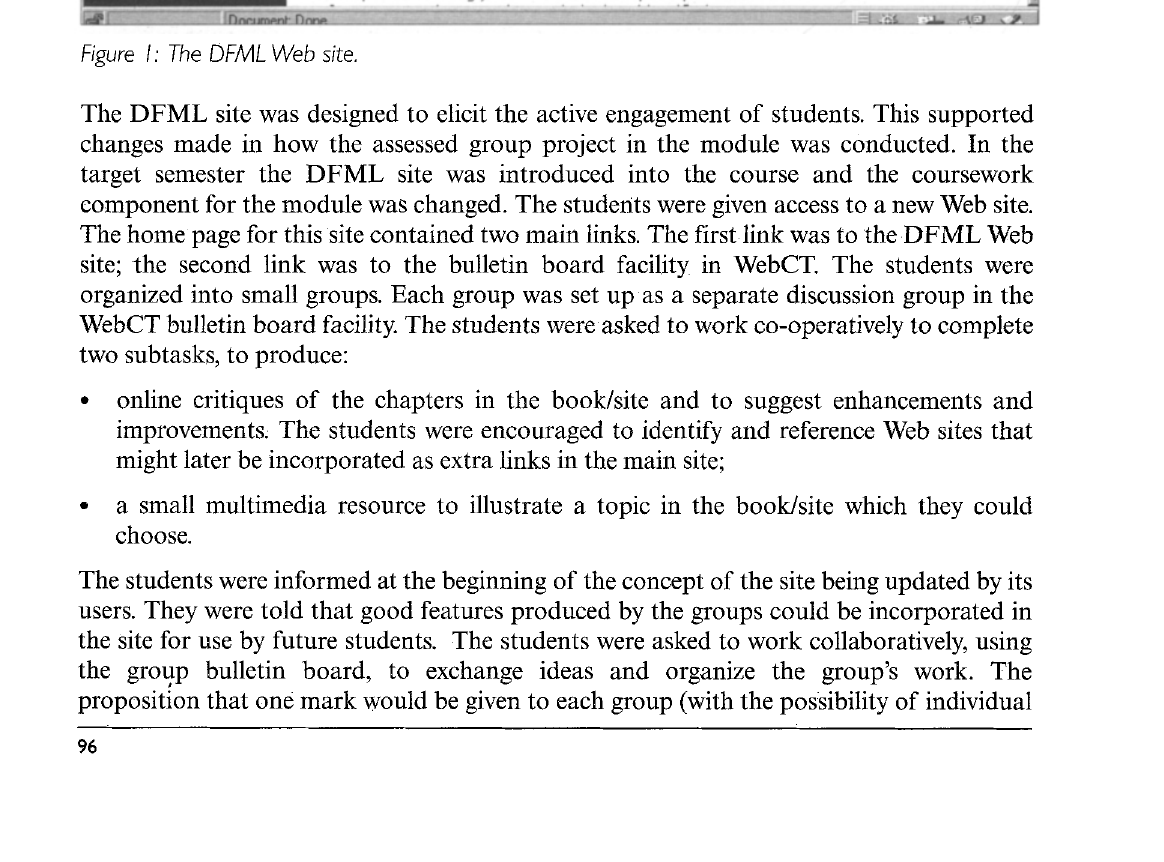
Figure I: The DFML Web